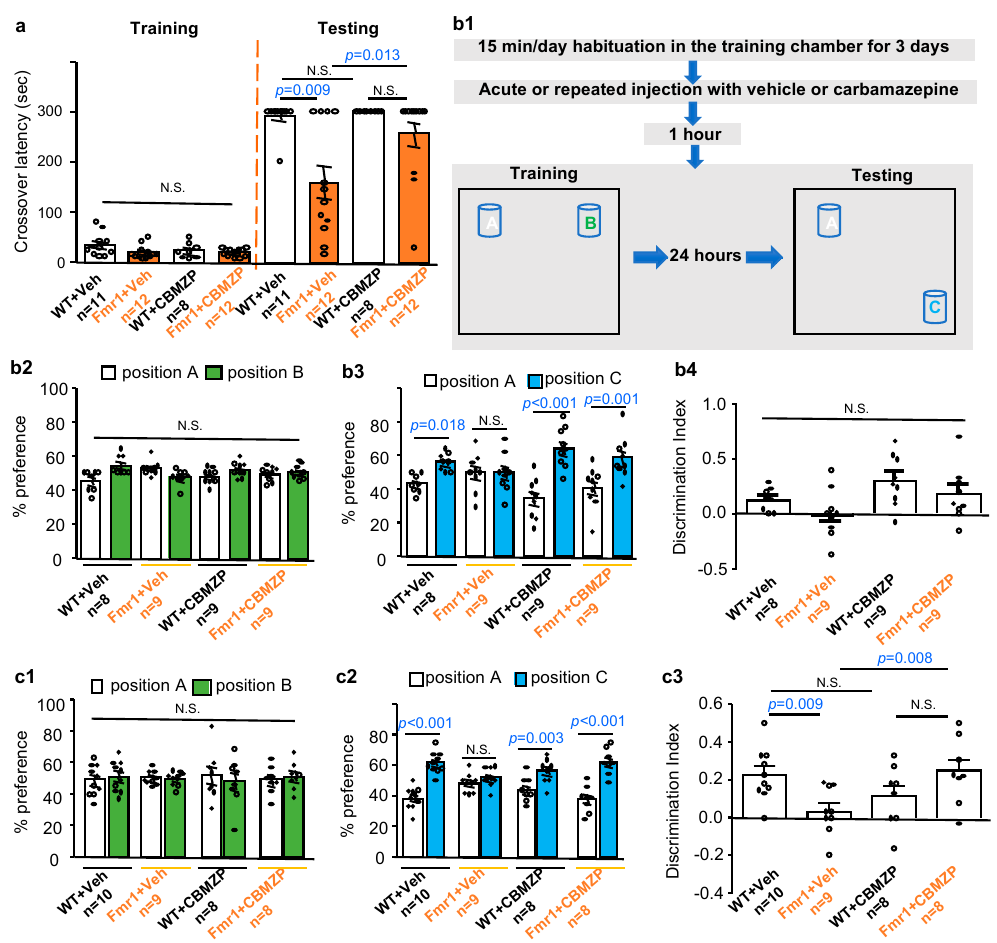
genotype X treatment interaction: F 1, 31 = 0.002, p = 0.968). Interestingly, Fmr1 KO mice receiving repeated daily administration of carbamazepine for 8 days displayed normal behavior during training (Figure 2(c1)) (genotype e ff ect: F 1, 62 = 0.000, p = 1.000; treatment e ff ect: F 1, 62 = 0.000, p = 1.000; genotype X treatment interaction: F 1, 62 = 0.003, p = 0.959). They showed improved object location memory (Figure 2(c2)) (vehicle: p = 0.299; carbamazepine: p < 0.001) and object discrimination index during testing (Figure 2(c3)) (genotype e ff ect: F 1, 31 = 0.396, p = 0.534; treatment e ff ect: F 1, 31 = 0.846, p = 0.365; genotype X treatment interaction: F 1, 31 = 9.819, p = 0.004).